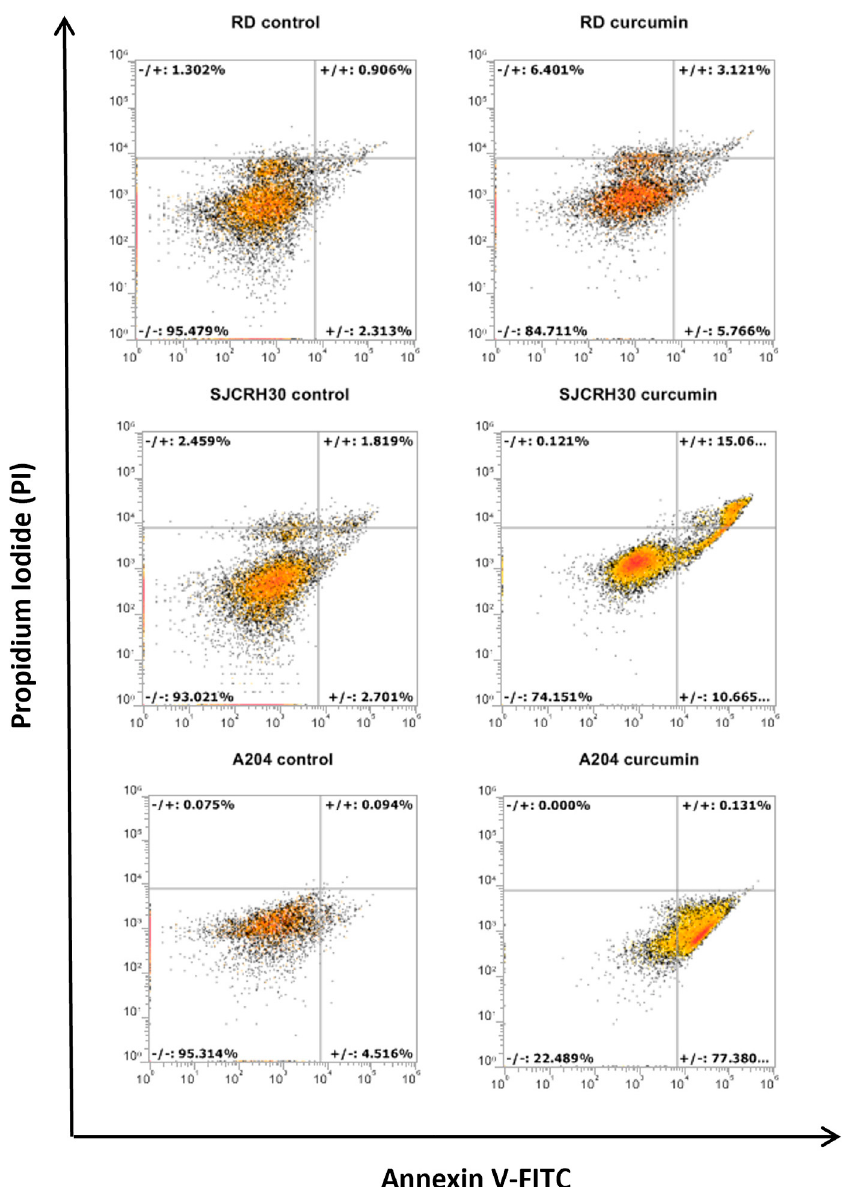
Figure 2. Curcumin treatment induces apoptotic cell death. Rhabdomyosarcoma cell lines (A204, RD, and RH30) were treated for 24h with 20 µ M of curcumin. Cells were stained with Annexin V-FITC/PI and analyzed by flow cytometry. The dot plots are representative of three independent